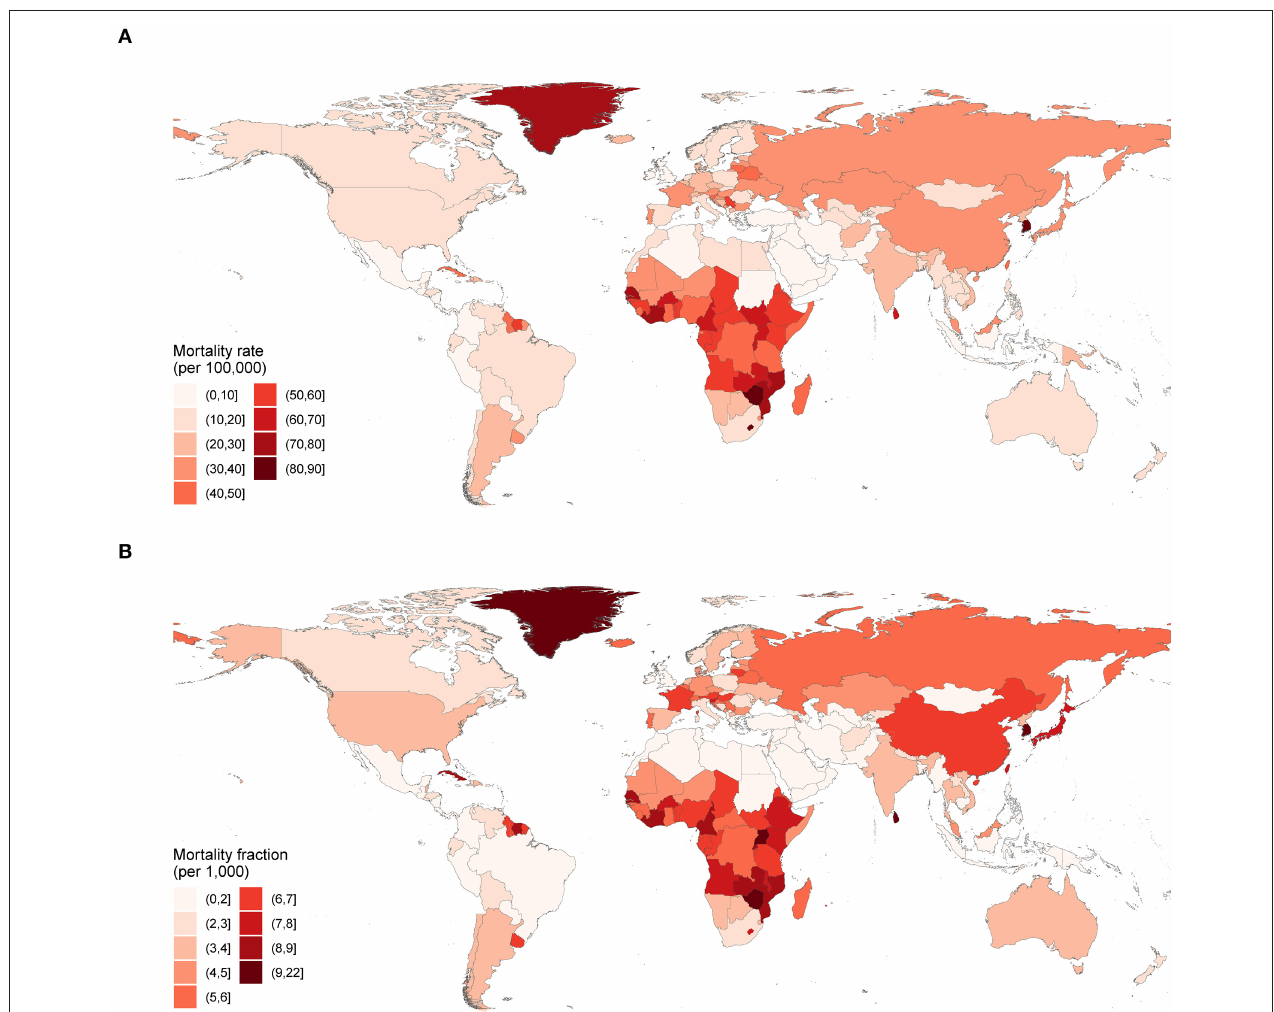
FIGURE 4 | Mortality rates (A) and mortality fractions (B) from suicide for the elderly in 2017. to the restricted cubic spline curve ( Supplementary Figure 5